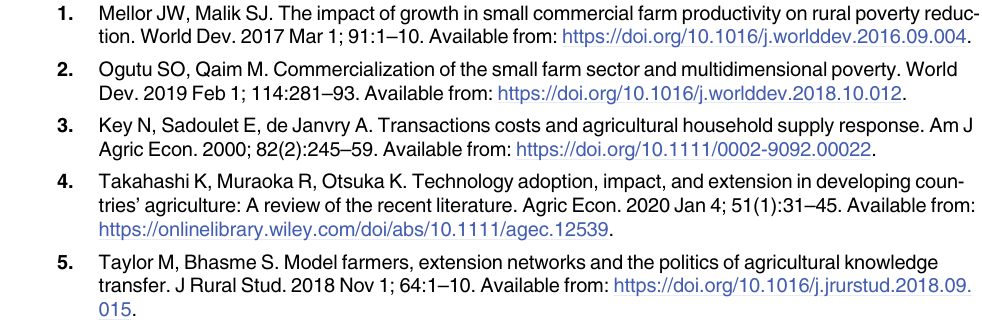
S11 Table. Oster bounds. S12 Table. L1 measure of imbalance before and after coarsened exact matching. S13 Table. Estimated associations based on coarsened exact matched